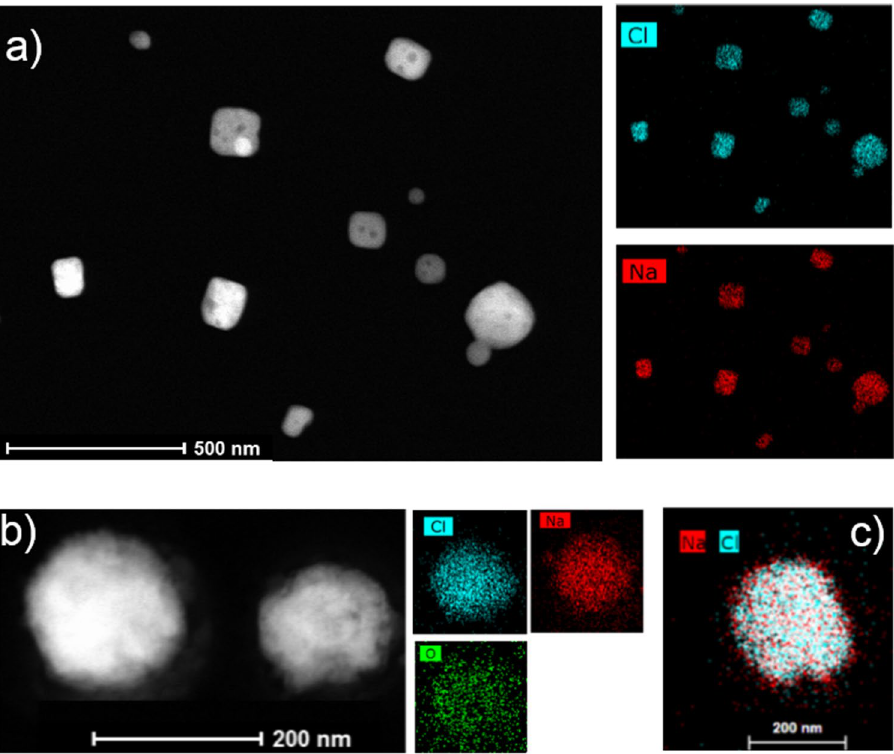
Figure 4. Effect of ageing on particle elemental composition. Microscopy images (STEM-EDX) of fresh ( a ) and aged ( b ) NaCl particles. Additionally, the elements found in the fresh and aged particles are illustrated. c) overlap of Na and Cl signals in the aged